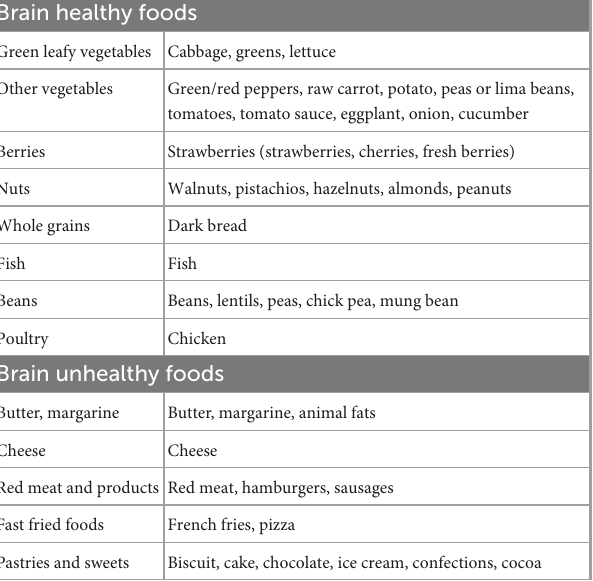
TABLE 1 Mediterranean-DASH Intervention for Neurodegenerative Delay (MIND) diet components. Brain healthy